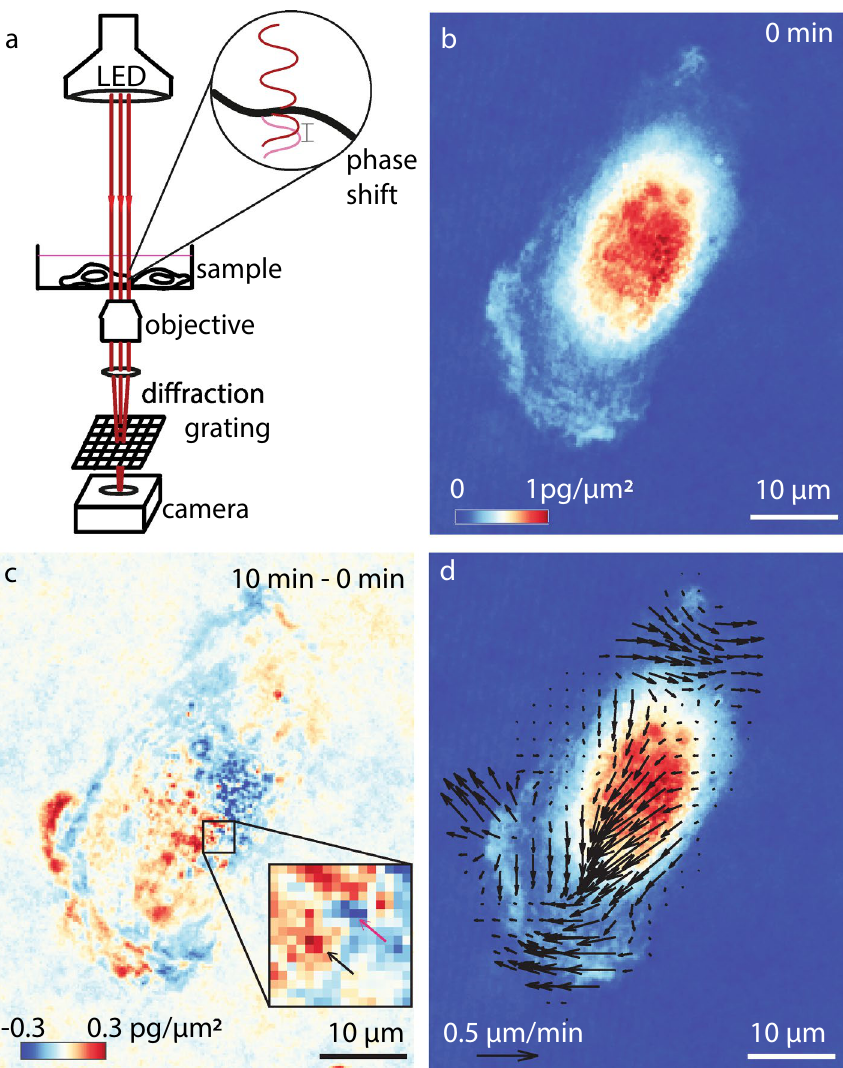
Figure 1. Quantitative phase velocimetry (QPV) measures intracellular dry mass movement. ( a ) Quantitative phase imaging (QPI) measures the phase shift of light passing through a cell, which is used to compute the dry mass distribution in cells over time. ( b ) Dry mass distribution in RPE cell imaged at 120X magnification, at t = 0 min. The scalebar indicates 10 µm length. ( c ) The difference in QPI mass distribution of the RPE cell in ( b ) from an image taken at t = 10 min later minus the image at 0 min reveals cell motion. The inset in ( c ) shows a 15 × 15 pixel interrogation window that illustrates the change in position of an individual subcellular feature from the position marked with a red arrow to the position marked with a black arrow. The color scale shows dry mass difference between frame at time 0 and 10 min (red: large increase in mass, blue: large decrease in mass). ( d ) The resulting intracellular biomass velocity field computed using quantitative phase velocimetry (QPV). Velocity magnitude indicated with a 0.5 µm/min